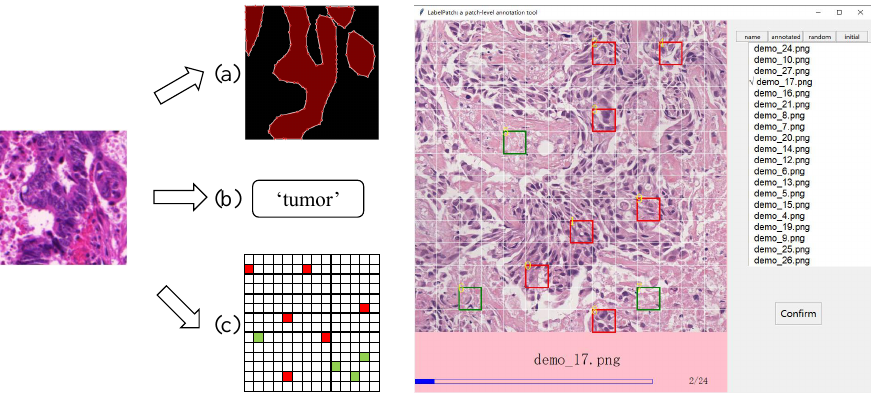
Figure 1. Left: The illustration of different types of labels. ( a ) Pixel-level label, where the red area denotes tumor region and the black area denotes non-tumor region. ( b ) Image-level label, suggesting that the image contains tumor region. ( c ) Patch-level label (proposed), where the red patches and green patches are manual annotations indicating tumor and non-tumor regions, respectively. Right: A software we developed for sparse patch